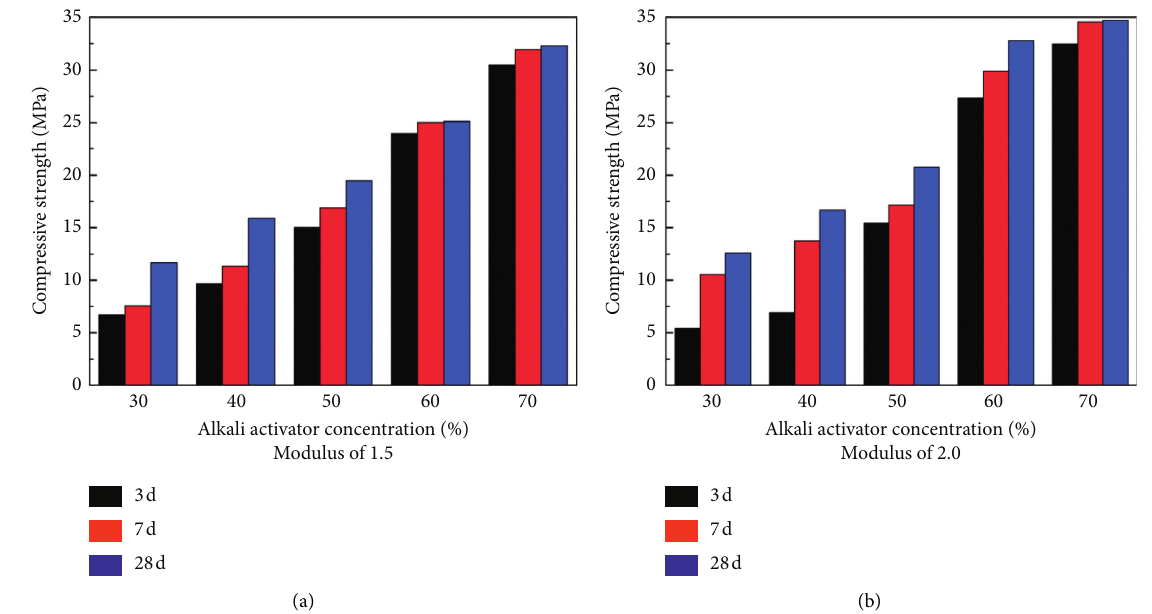
Figure 1: Influence of the activator concentration on the compressive strength of geopolymers.